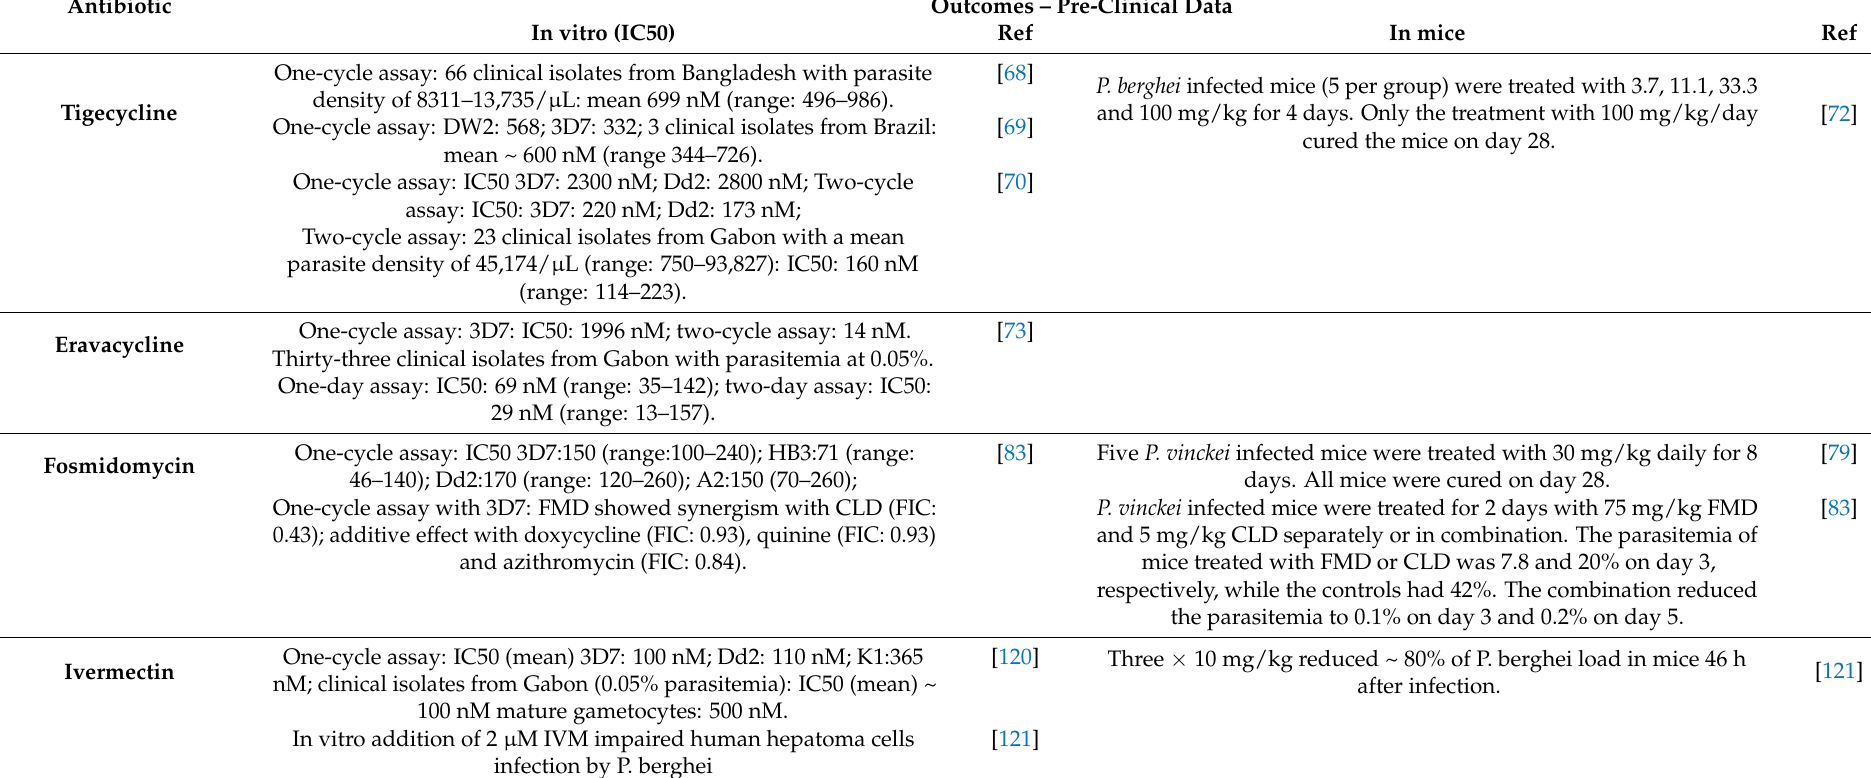
Table 1. Summary of the pre-clinical data of fast-acting